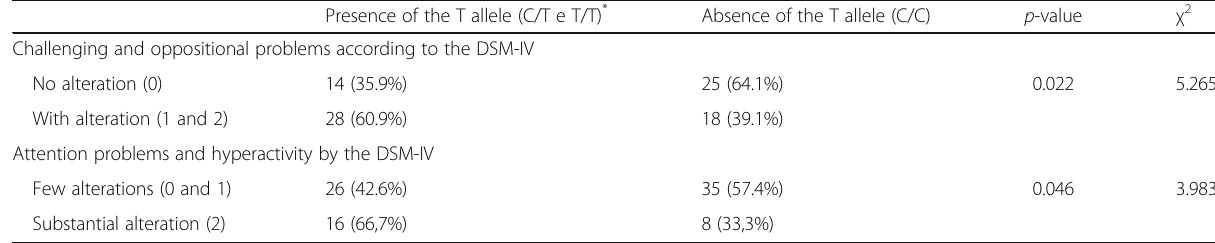
Table 3 Significant associations between the results of the CBCL/6-18 and the rs6277 polymorphism of the DRD2 gene Presence of the T allele (C/T e T/T)